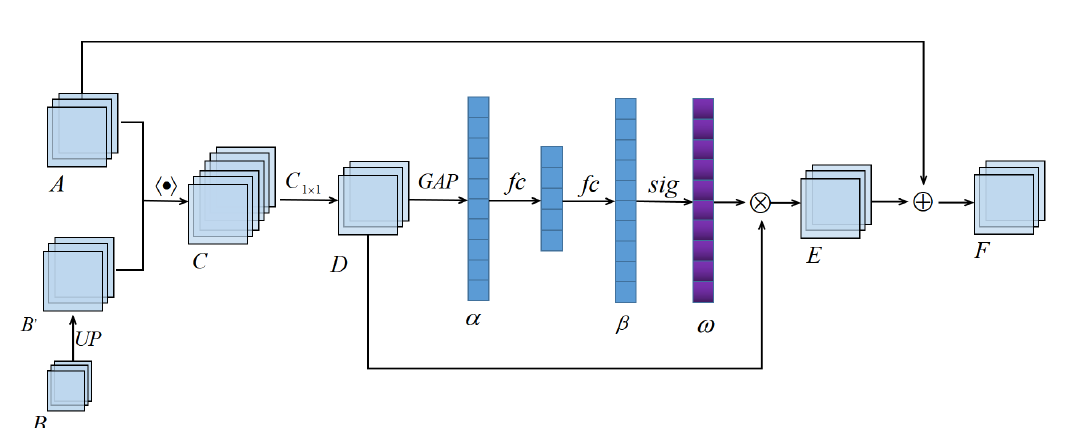
Figure 2. Structure of the adaptive fusion module. A is a low-level feature map. B is a high-level feature map. B’ is a feature map obtained by B. C is a feature map of A and B’ combined by channel. D is a feature map of the channel changed by C. E is the feature map adjusted with channel weights. F is the final fusion feature